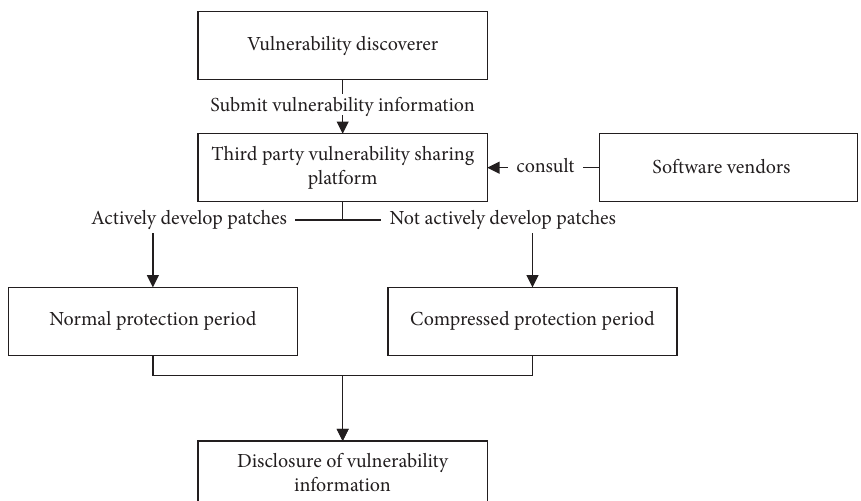
Figure 1: Te network security vulnerability disclosure and patch release